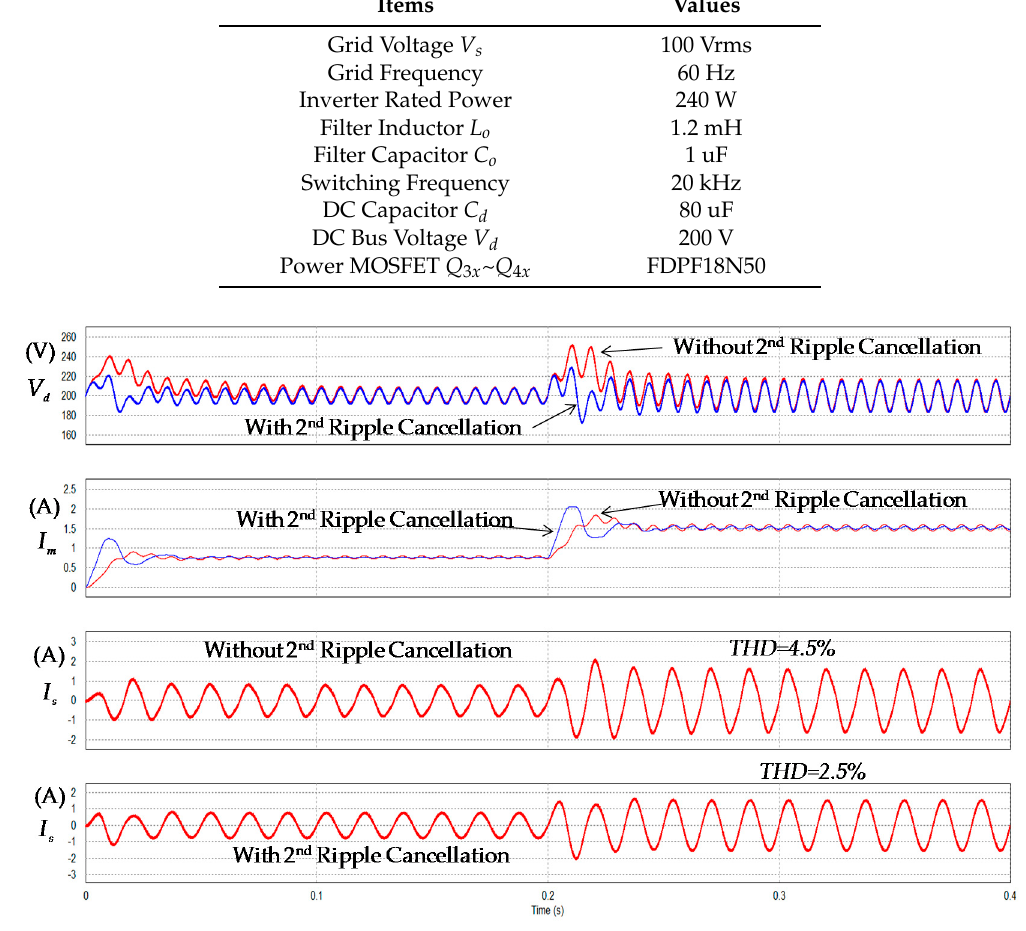
Figure 5. Simulation results of inverter with and without proposed 2nd voltage cancellation control.